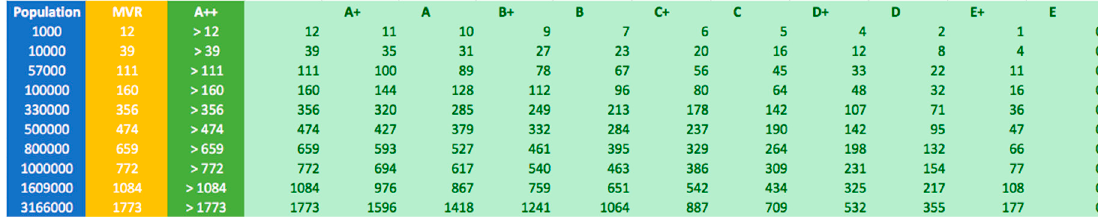
Figure 2. Table that represents the intervals of CID values for different amount of population.